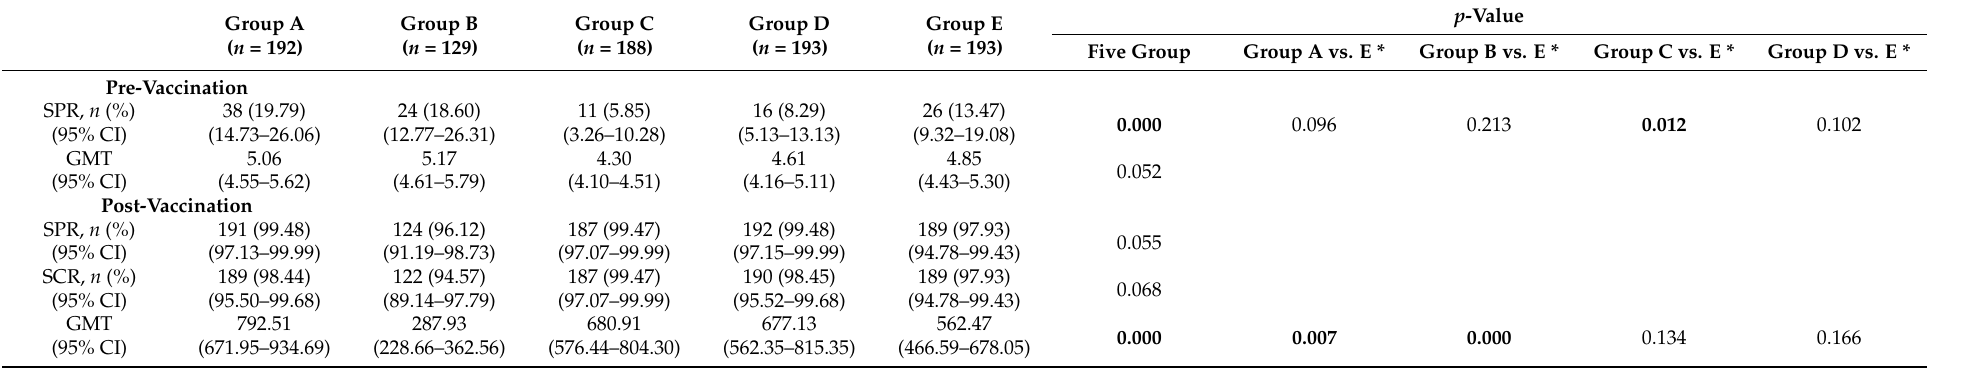
Table 2. Antibody responses to EV71 pre- and post-vaccination in the per-protocol populations.